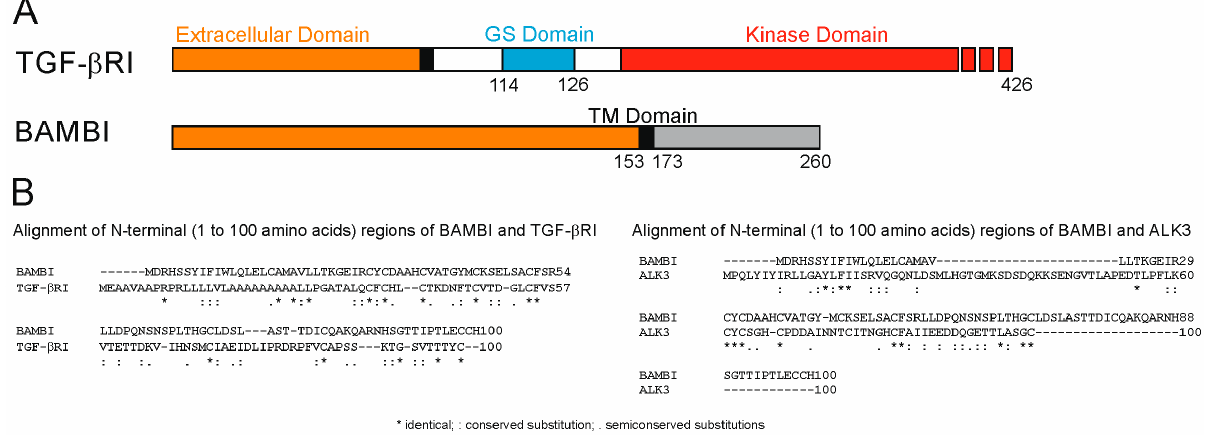
Figure 2. The structure of TGF- β type I receptor and BAMBI protein. ( A ) Domains of TGF- β RI and BAMBI protein (Glycine–serine-rich domain = GS domain; Transmembrane domain = TM; numbers in the figure refer to amino acid positions). ( B ) Alignment of the N-terminal 100 amino acids of TGF- β RI (NCBI Reference Sequence: NP_001124388.1) and BAMBI (NCBI Reference Sequence: NP_036474.1) as well as ALK3 (NCBI Reference Sequence: NP_001393518.1) and BAMBI using Clustal Omega.